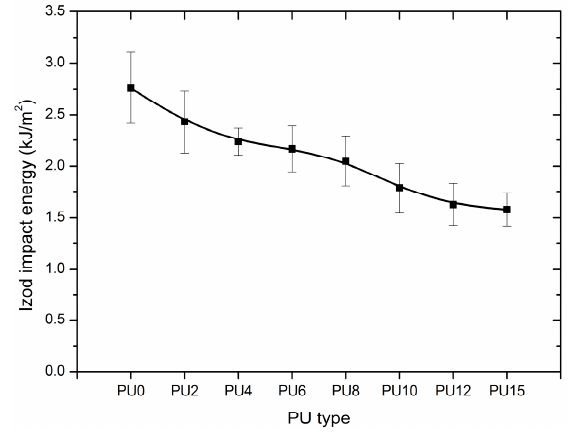
Figure 13. Impact energy, (PU0–PU15 are types of PU, and PU6—PU which contained 6% PEG).